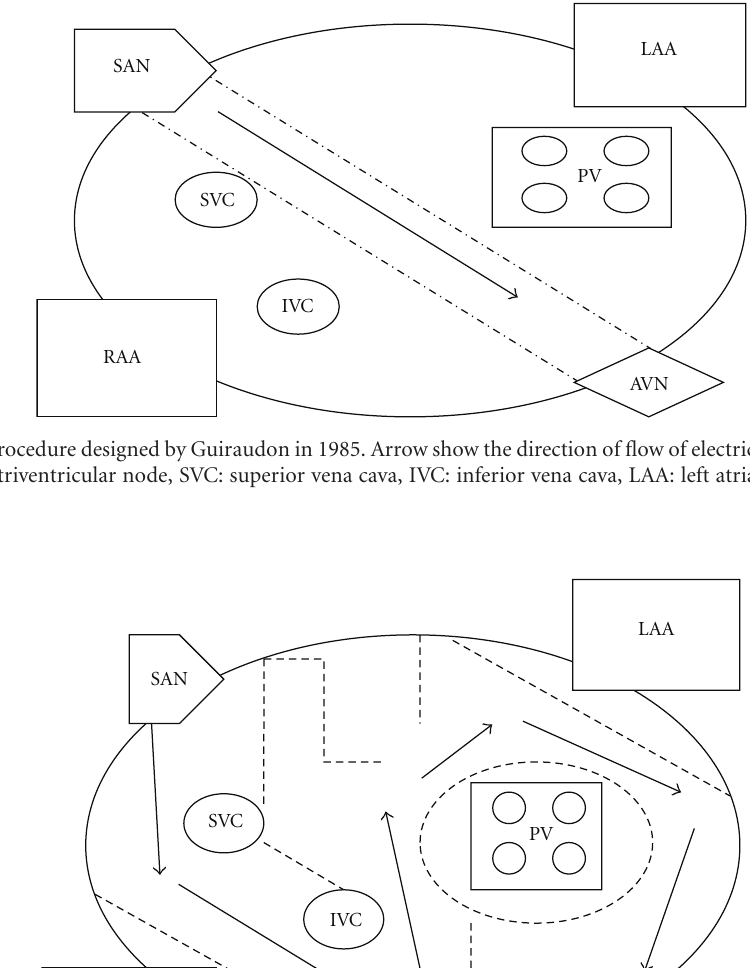
it is the most e ff ective curative therapy for AF yet devised